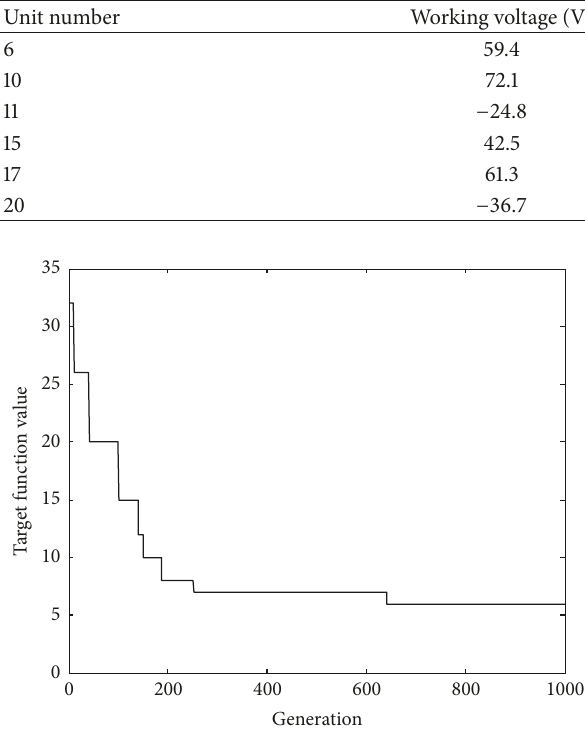
Table 2: Optimal working voltage of piezoelectric actuators under optimal configuration.